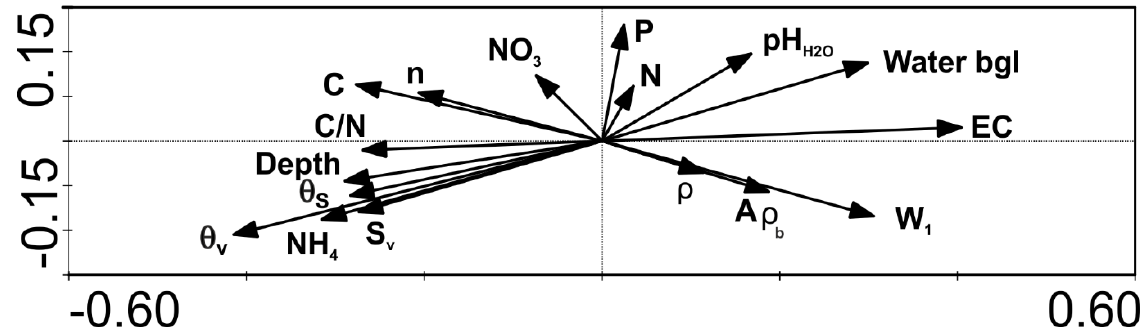
Figure 4. Unconstrained ordination diagram (DCA) of all environmental variables (arrows) shown as the passive ones. Abbreviations of variables: Water bgl = water table depth (below ground level), Depth = depth of residual peat, n = total porosity, ρ = bulk density, ρ = specific density, A = ash content, S = volumetric b v shrinkage, θ = volumetric moisture content, θ = saturated moisture content, W = water-holding capacity v s 1 index, C = total carbon, N = total nitrogen, NO = nitrate nitrogen, NH = ammonium nitrogen, P = available 3 4 phosphorus, EC = corrected electrical conductivity.